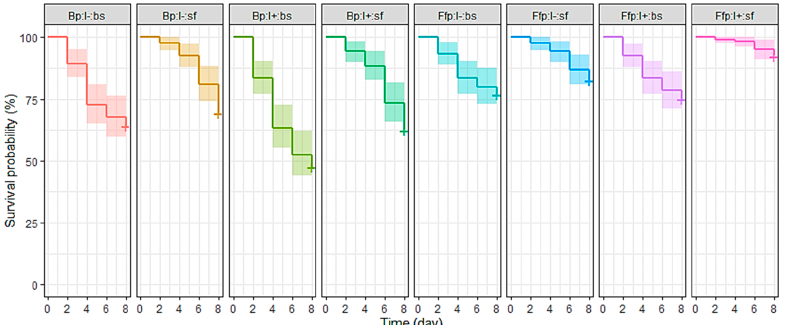
Figure 2. Survival curves of Myzus persicae for eight days after exposure to a spray of B. bassiana and/or release on B. bassiana- inoculated plants. Treatments were based on combinations of plant type (Bp: B. bassiana -inoculated plant; Ffp: fungal-free plant), insect infectious status (I+: viruliferous; I − : non-viruliferous) and insect spraying (bs: with B. bassiana spore suspension; sf: with spore-free solution). n = Ffp:I − :sf, Ffp:I − :bs, Ffp:I+:sf and Ffp:I+:bs = 120; Bp:I − :sf = 80; Bp:I − :bs = 70; Bp:I+:sf = 75; and Bp:I+:sf = 85. Table 3. Pair-wise comparison of Myzus persicae survival curves for eight days after exposure to a spray of B. bassiana and/or release on B. bassiana -inoculated plants. Treatments were based on combinations of plant type (Bp: B. bassiana -inoculated plant; Ffp: fungal-free plant), insect infectious status (I+: viruliferous; I − : non-viruliferous) and insect spraying (bs: with B. bassiana spore suspension; sf: with spore-free solution). n = Ffp:I − :sf, Ffp:I − :bs, Ffp:I+:sf and Ffp:I+:bs = 120; Bp:I − :sf = 80; Bp:I − :bs = 70; Bp:I+:sf = 75; and Bp:I+:sf = 85.